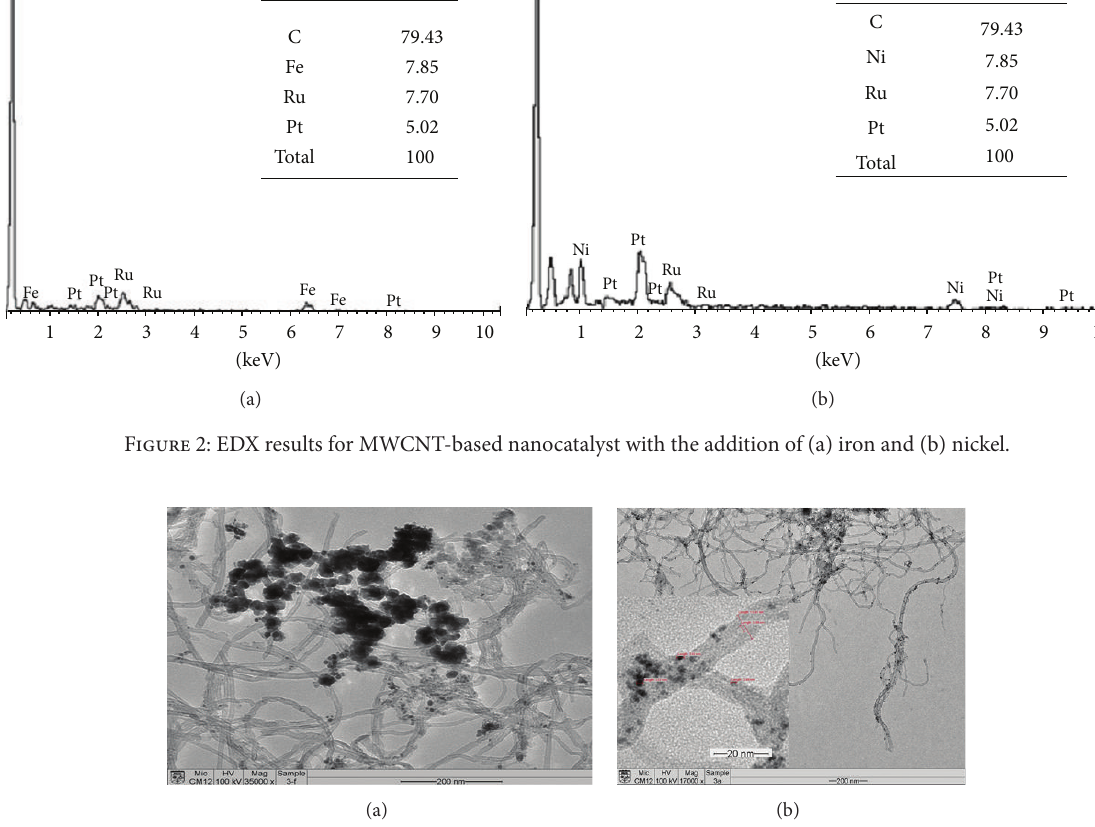
Figure 3: Morphologies of (a) PtRuFeNi/MWCNT and (b) PtRu/MWCNT.